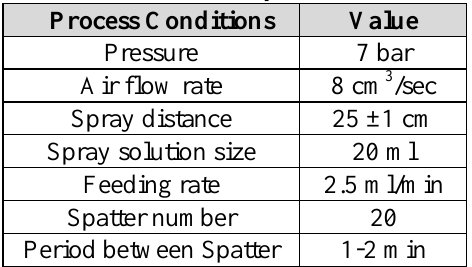
Table 2: Process